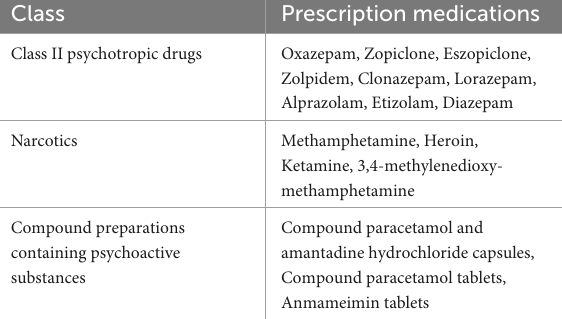
TABLE 1 Categories of PMA